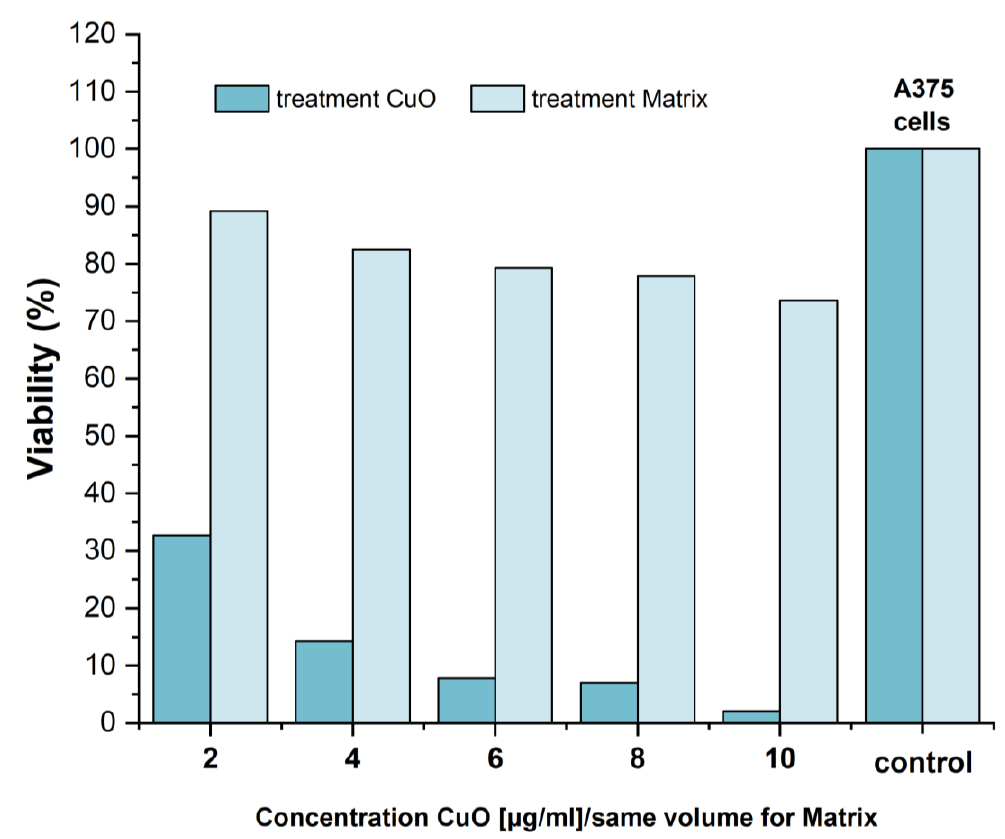
Figure 8. MTT cytotoxicity assay results using 10-day incubation liquid extracts from C6 glass in different concentrations; n = 5.